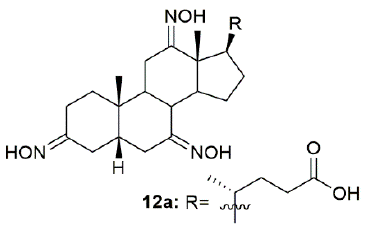
Figure 15. Bile acid derivative with anti-inflammatory activity.